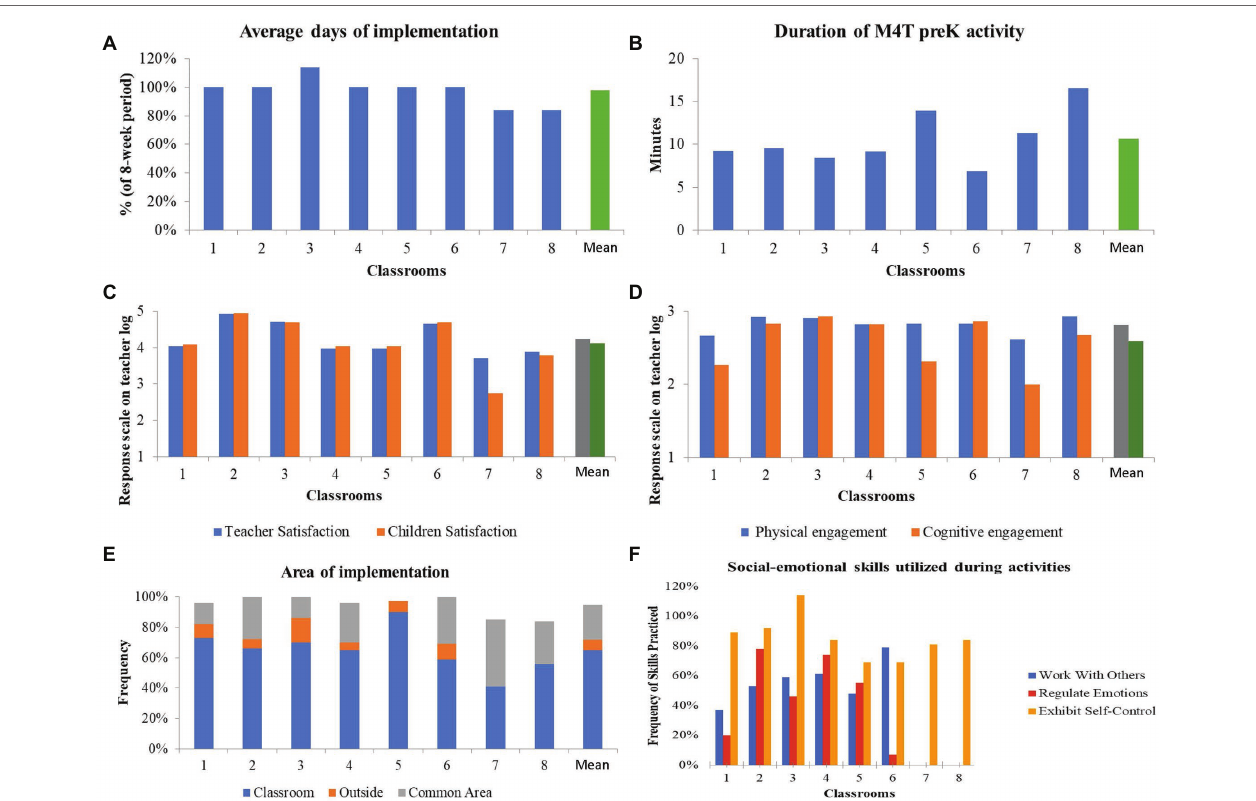
FIGURE 3 | Process Evaluation Results for Intervention Class. Panel A: Days of Implementation, Panel B: Average Duration of a M4T preK-K Activity, Panel C: Teacher and Student Satisfaction from Implementation, Panel D: Level of Physical and Cognitive Engagement during Implementation, Panel E: Area of Implementation, and Panel F: Social-Emotional Skills (Working with Others, Regulating Emotions, Exhibiting Self-Control) Practiced During